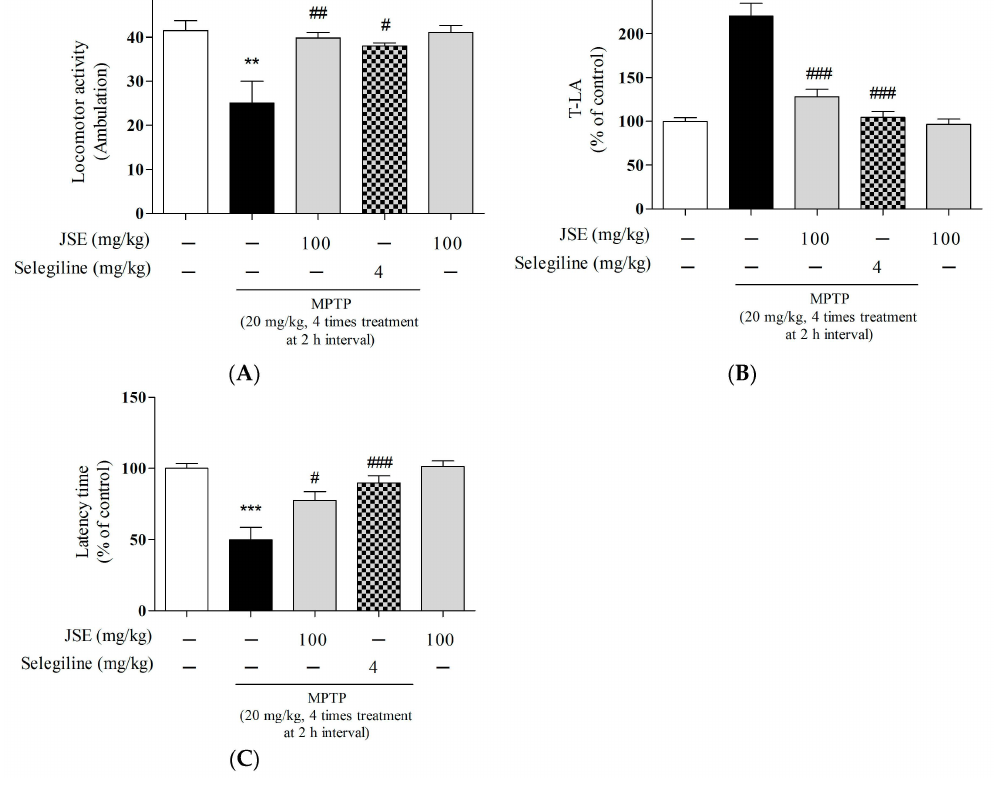
Figure 8. Effect of JSE on MPTP-induced movement impairment in mice. JSE (100